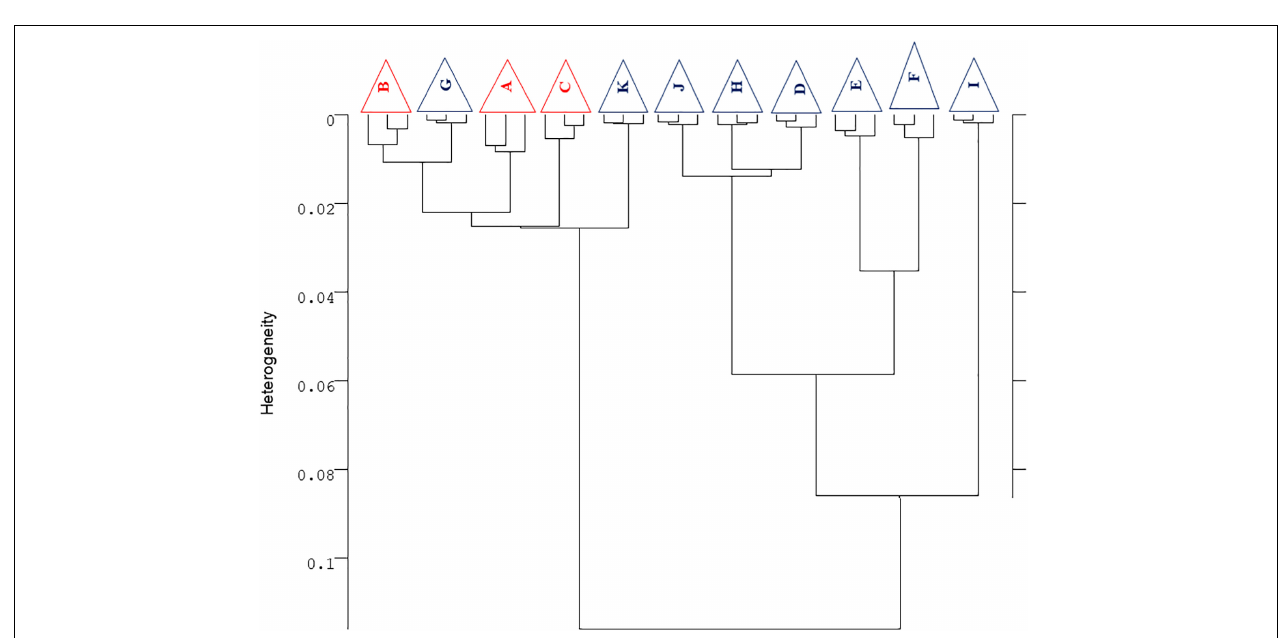
FIGURE 5 | Principal component analysis plot based on volatile metabolites produced by S. cerevisiae EC1118 (EC) and S. cerevisiae AWRI 796 (AW) strains in grape must fermentations carried out by each Research Unit (RU) on volatile metabolites. Case projection, variable projection is in Supplementary Figure 3 .